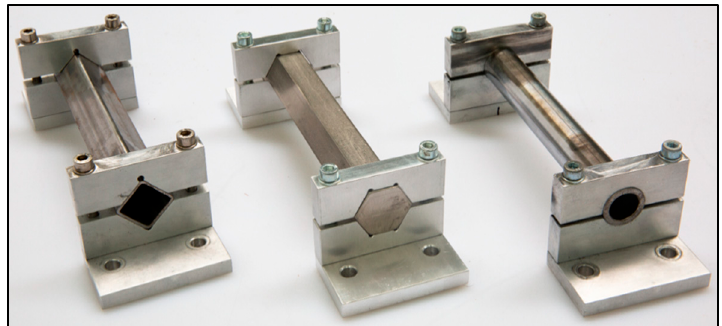
Figure 3. Square, hexagonal and circular geometry variation for sample clamping.